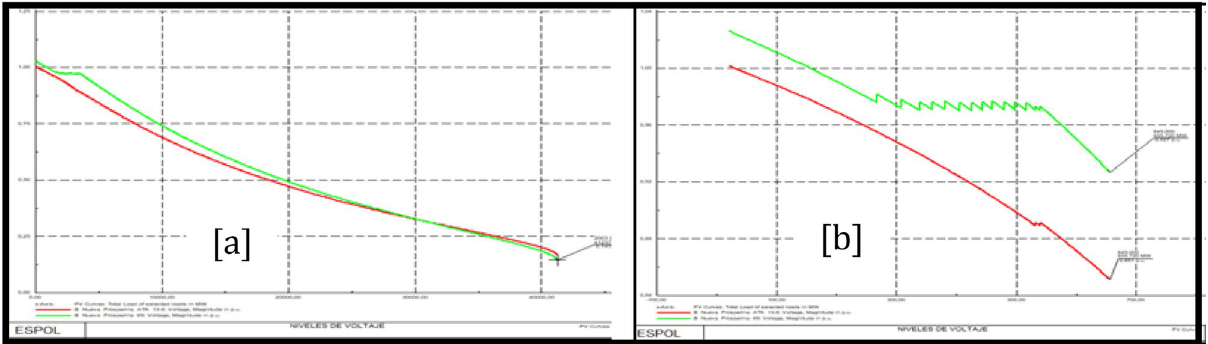
Figure 13. Stability PV before load model ( a ) and PV after load model ( b ) Nueva Prosperina 69 kV bus.